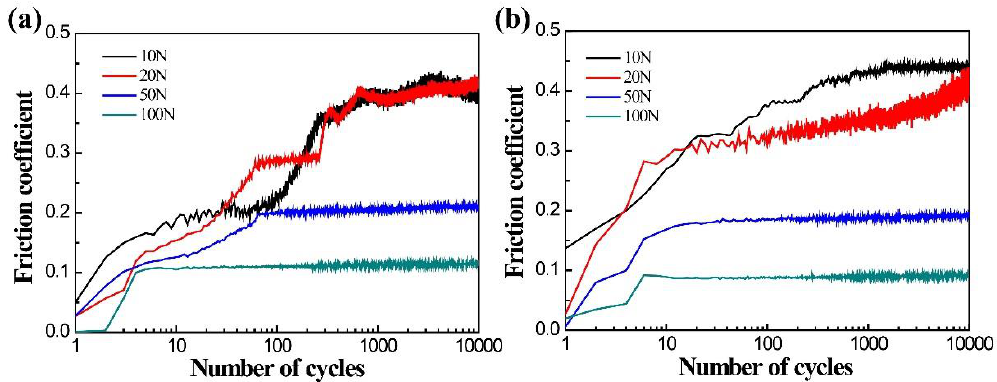
Figure 3. Friction coefficient of DU ( a ) and Ti/TiN on DU ( b ) under various normal loads.